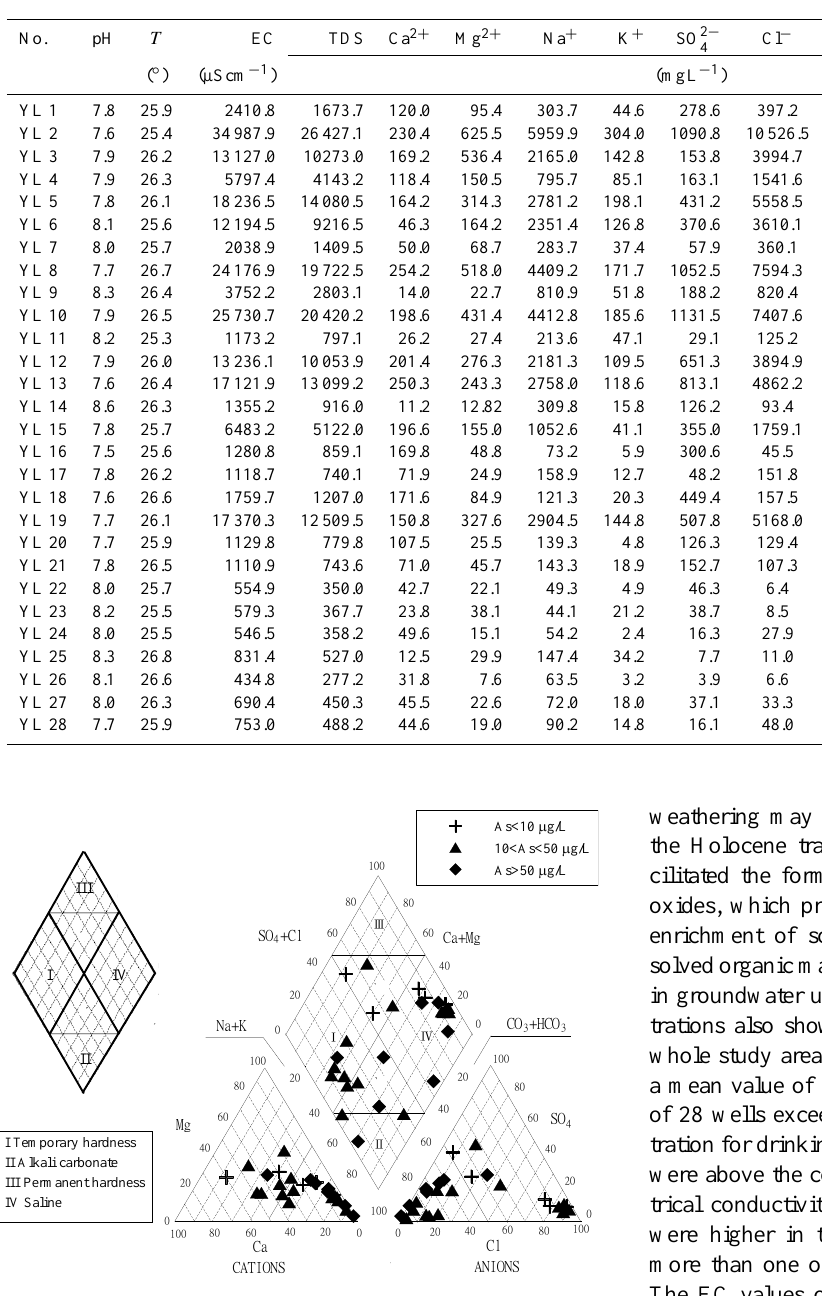
Fig. 2. Piper plot of sampled groundwaters in the littoral area of the Choushui River alluvial